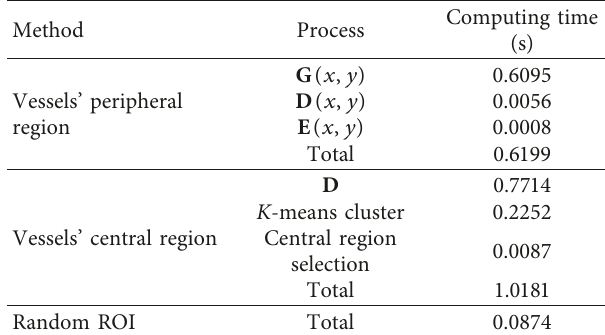
Table 3: Time requirement comparisons for 3 spectral extractions.